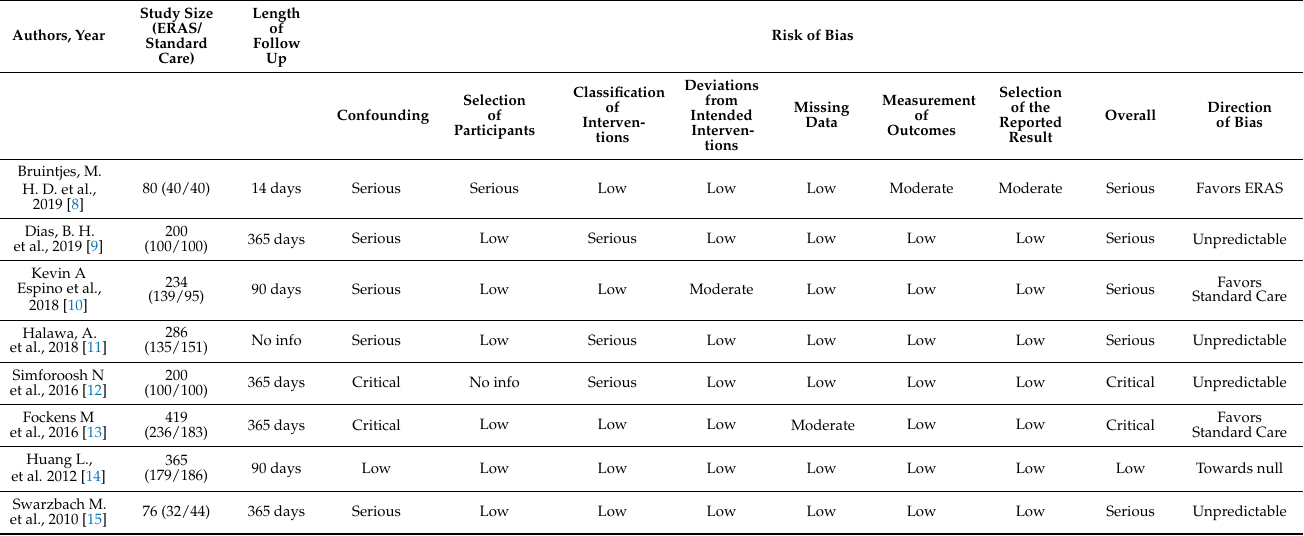
Table 1. Non-randomized studies: quality and risk-of-bias assessment.